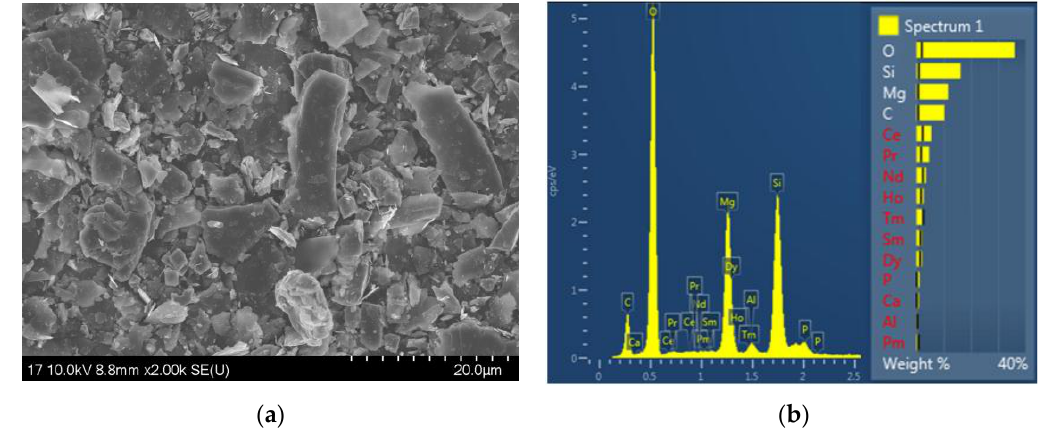
Figure 2. Field emission scanning electron microscopy (FE-SEM) ( a ) and energy-dispersive X-ray spectroscopy (EDX) ( b ) images of the pristine RE powder.